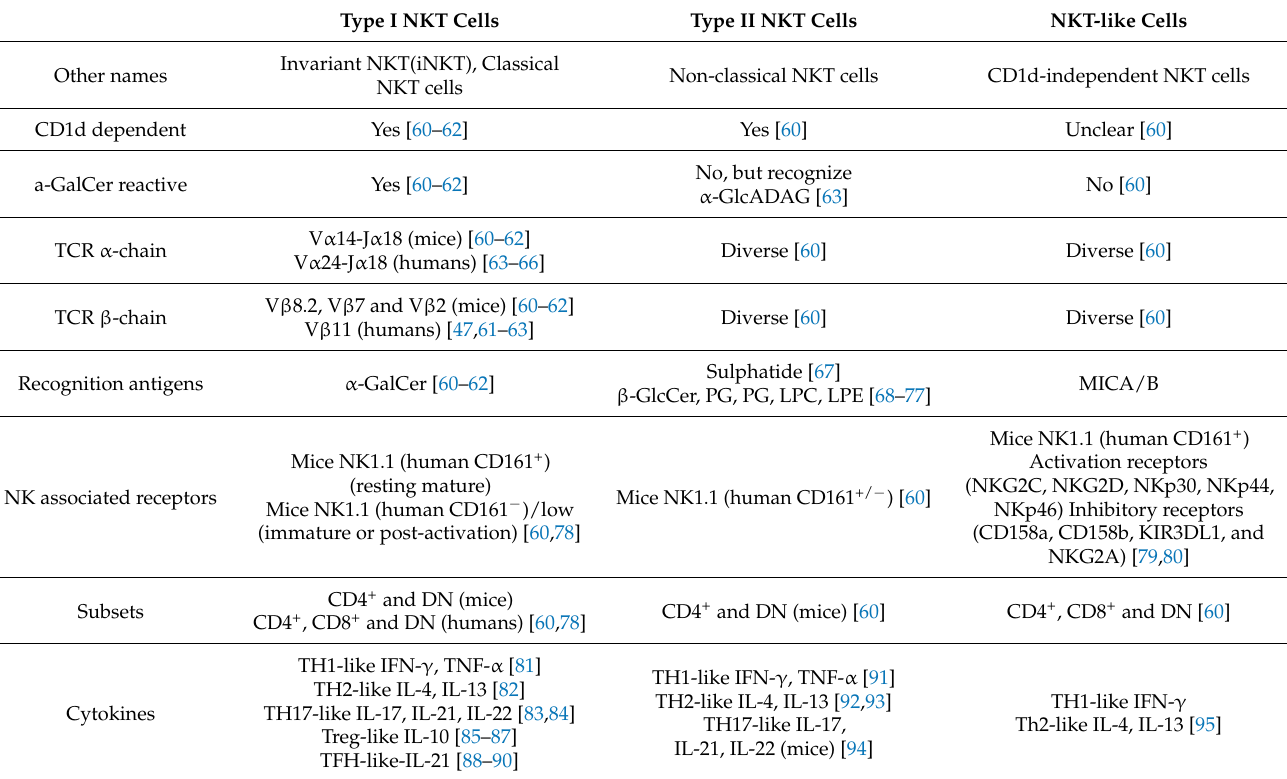
Table 1. List of NKT cells’ classification and